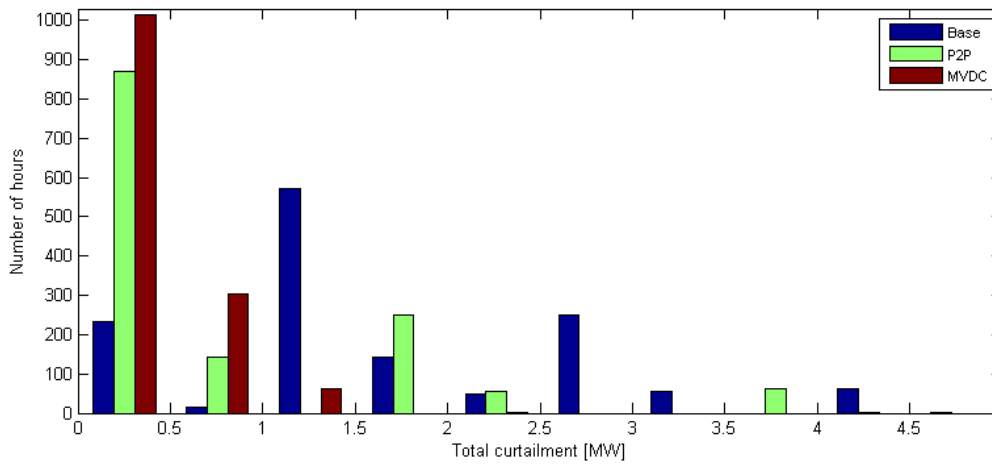
Figure 10. The distribution of total DG curtailment within the study